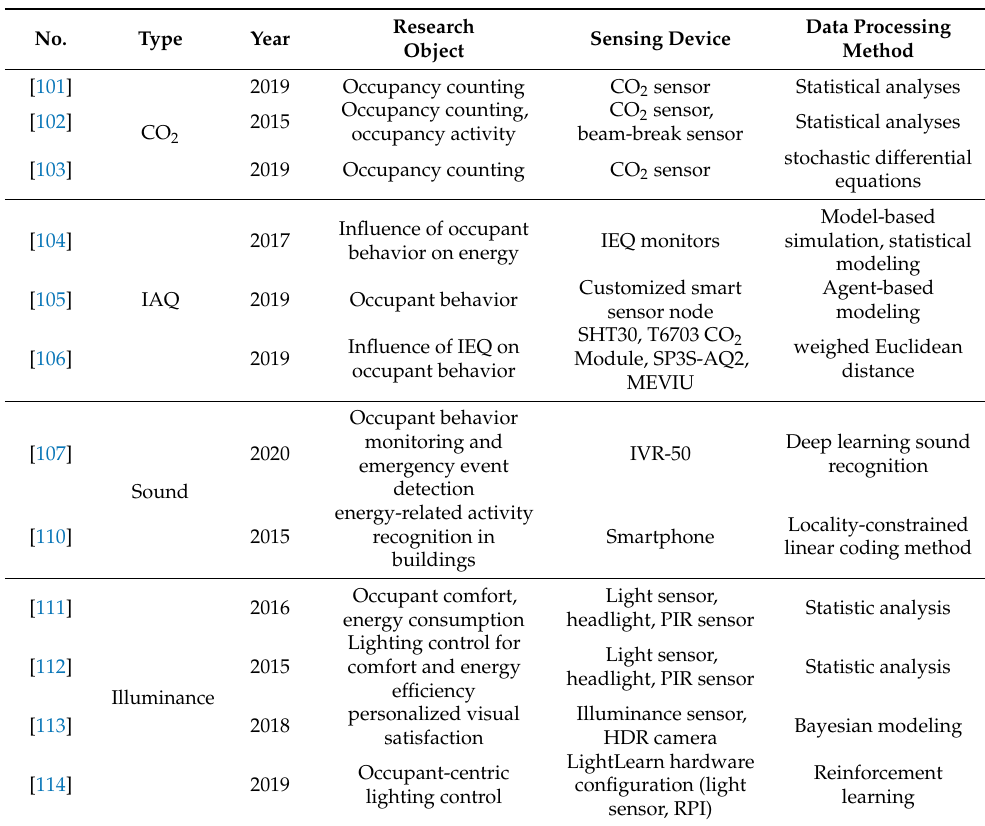
Table 7. The list of references for building environment